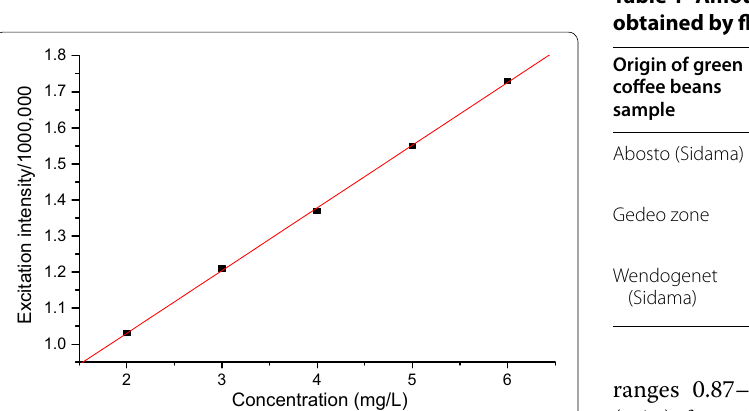
Fig. 4 Graph of concentration vs maximum fluorescence excitation